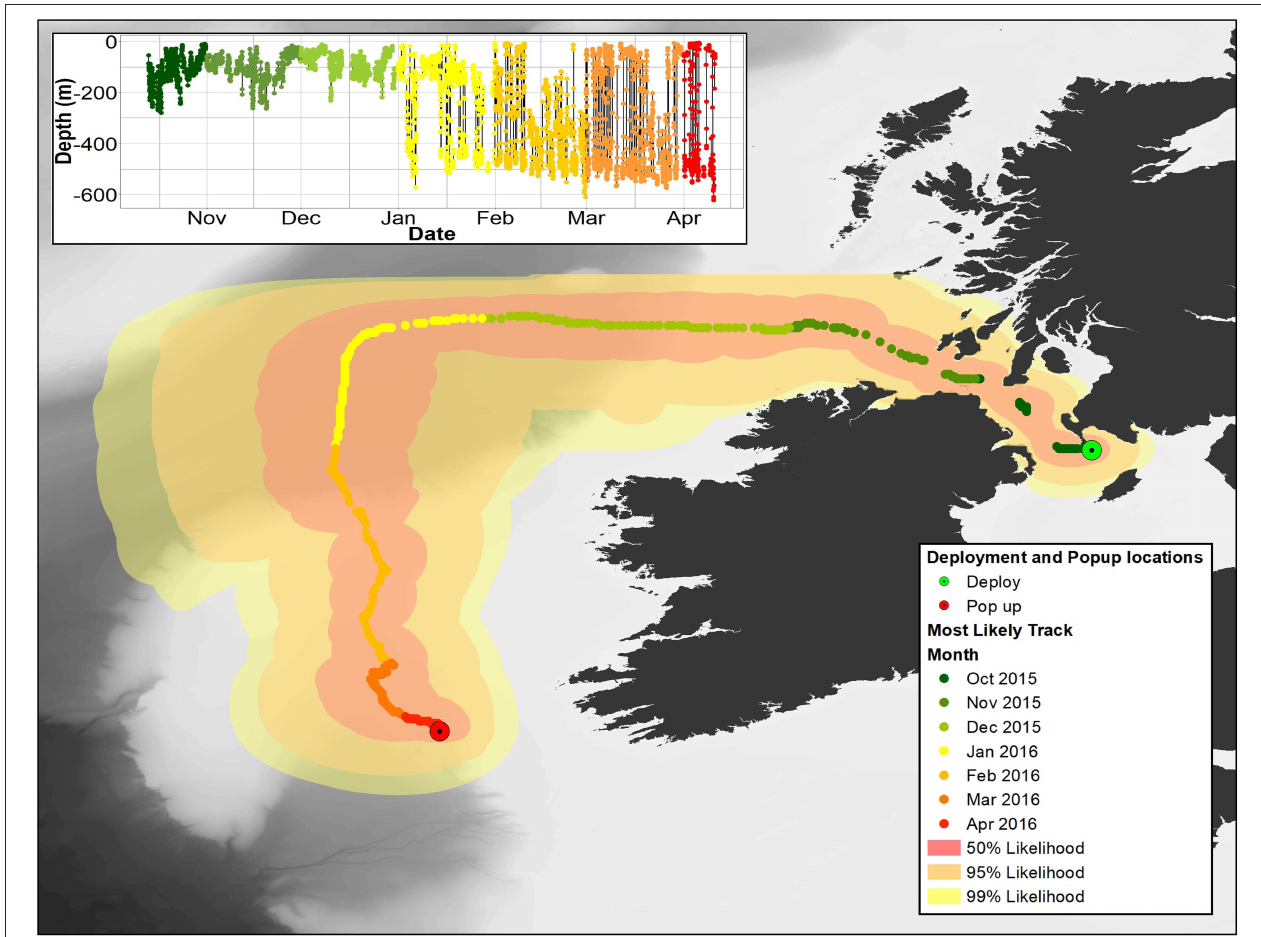
FIGURE 8 | Main image: most likely pathway for 153233 recreated using Wildlife Computers GPE3 model. 50, 95, and 99% confidence limits are also shown. Insert: depth data for 153233. In both panels, months are color coded as per the